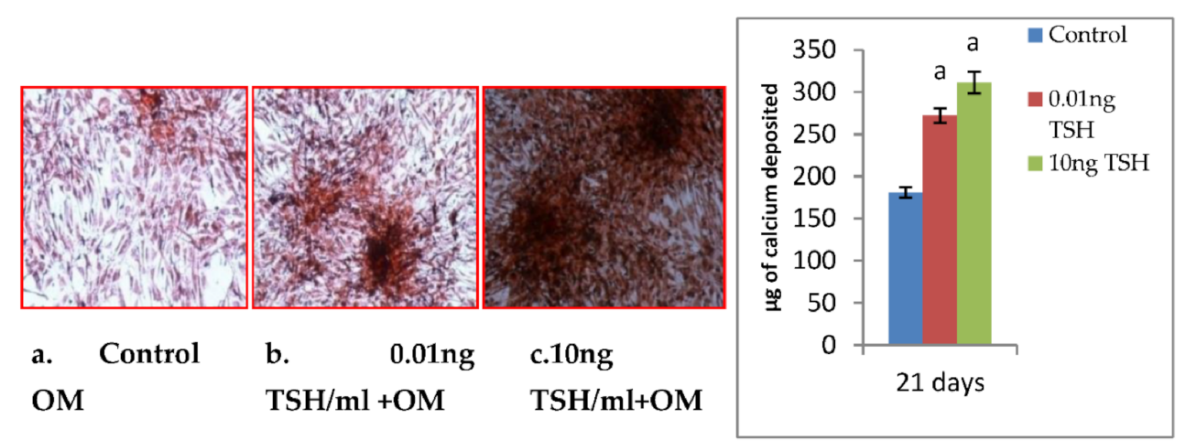
Figure 5. Effect of TSH on mineralization in SaOS-2 cells (Phase contrast Microscopy X 10). Each bar diagram shows mean ± SEM of three experiments; ‘a’ represents compared with control at p <